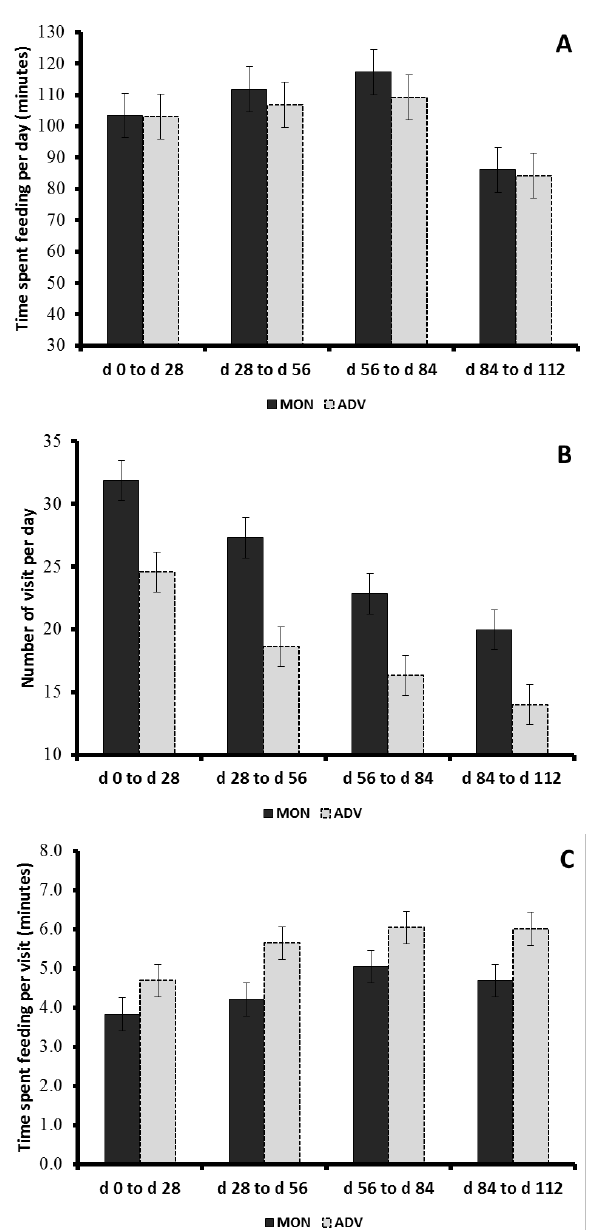
Figure 1. Supplement intake behavior of Nellore bulls finished on pasture with high concentrate supplementation, with monensin (MON) or a blend of live yeast and organic minerals (ADV). Time spent feeding per day ( A ), statistical effects: Period ( p < 0.01), Treatment ( p = 0.38), interaction Treat × Per ( p = 0.94); Number of visits per day ( B ), statistical effects: Period ( p < 0.01), Treat ( p < 0.01), interaction Treat × Per ( p = 0.74); Time spent feeding per visit ( C ), statistical effects: Period ( p < 0.01), Treat ( p < 0.01), interaction Treat × Per ( p =